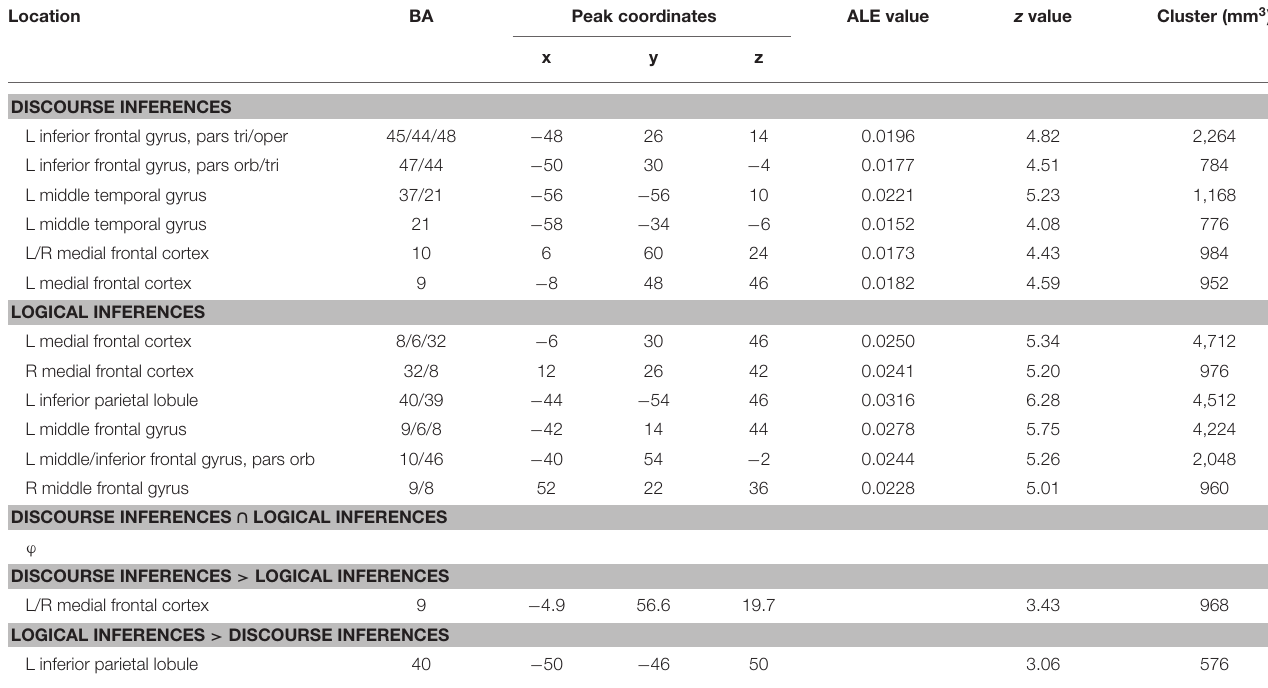
TABLE 4 | Regions are consistently activated across the experiments on discourse inferences and logical inferences. Location BA Peak